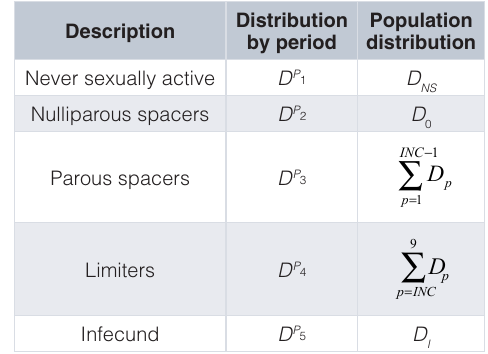
Table 2. Population distribution in the reproductive life course.